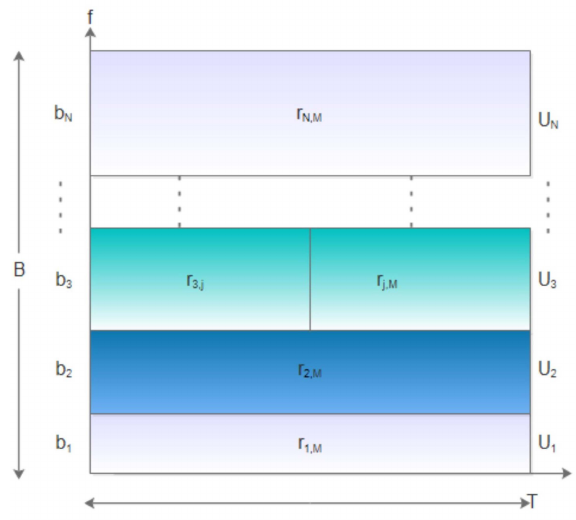
Figure 2. Resource allocation for nodes and